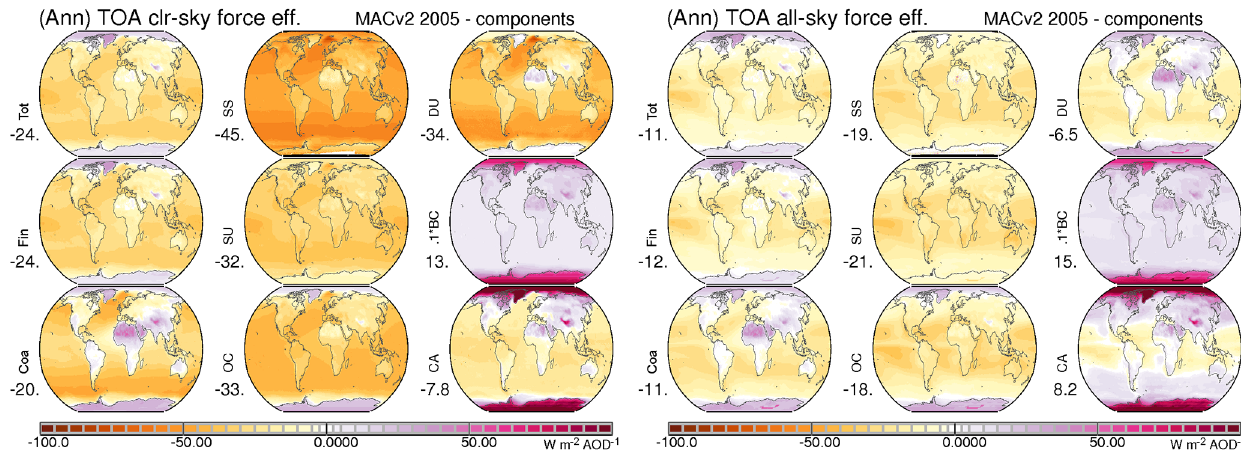
Figure 11. Annual maps for present-day direct component forcing efficiencies (per unit AOD) at the TOA for clear-sky (left frame) and for all-sky conditions (right frame) for total, coarse-mode and fine-mode aerosols (left column), for mainly scattering components (center column) of sea salt (SS), fine mode (SU) and organic matter (OC) (center column) as well as components with absorption (right column) of dust (DU), soot (BC) and for the combined carbon (CA = OC + BC). The large positive forcing efficiencies for BC (130Wm − 2 per unit AOD for clear sky and 150Wm − 2 per unit AOD for all sky) are divided by 10 to fit the common color scale. Global averages are presented below the